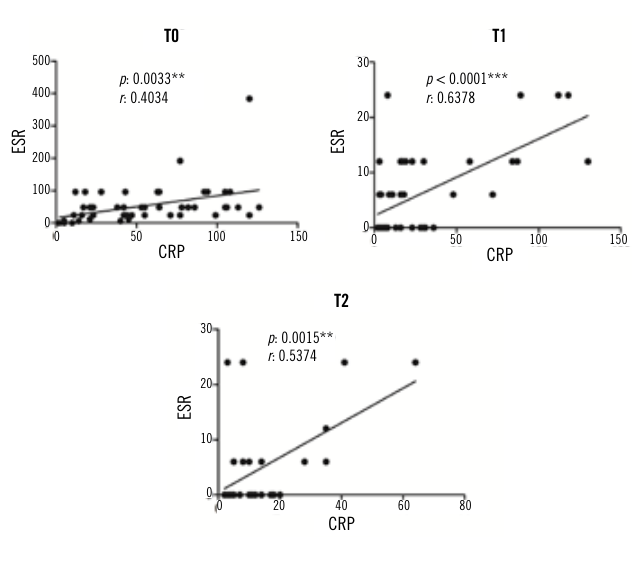
figurE 2 – Pearson’s correlation plot comparing p and r values between ESR and CRP at T0, T1, and